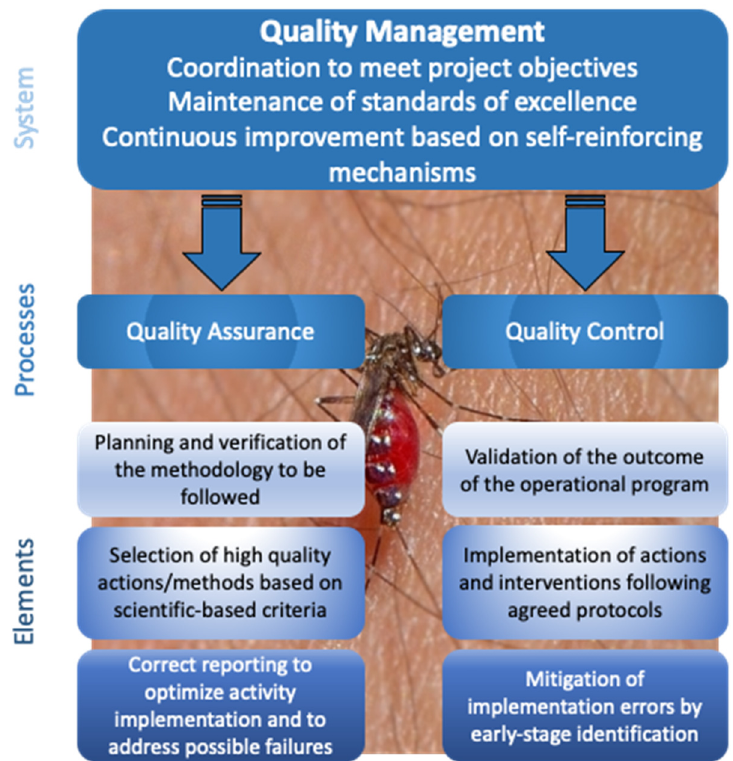
Figure 1. Schematic outline of quality management processes and elements (background: Aedes albopictus receiving blood meal from human arm, photo by Stihios Serafim).